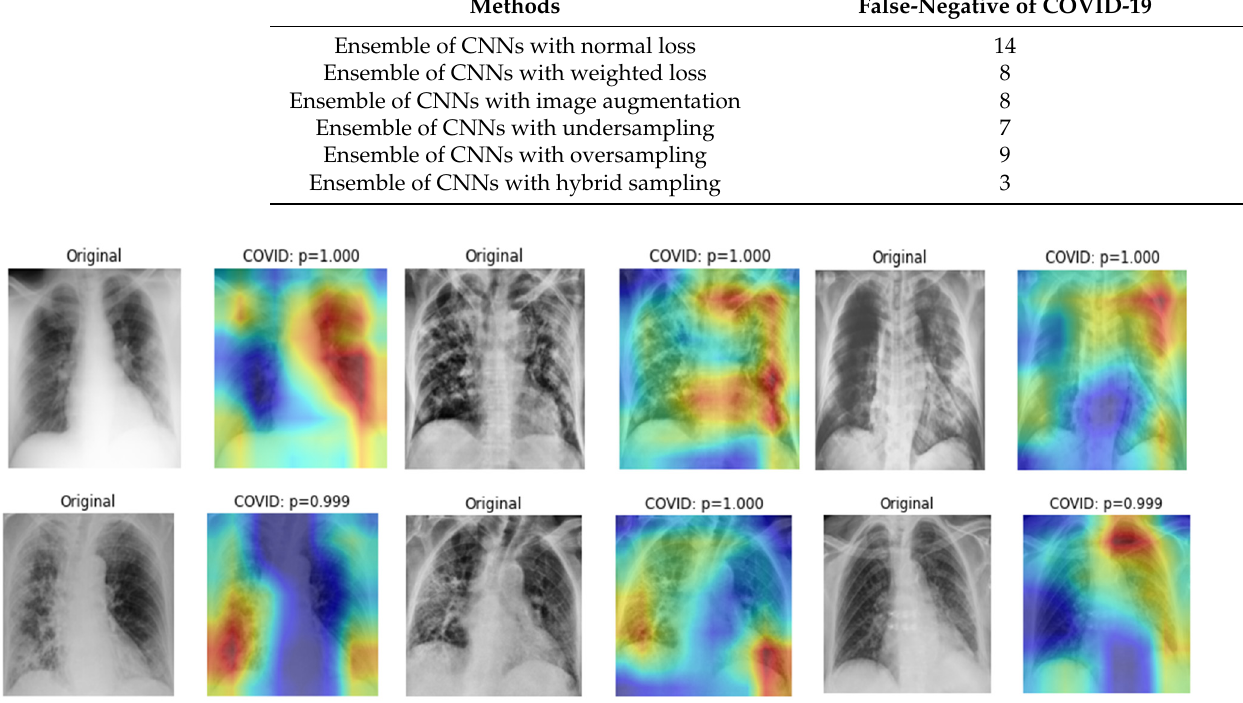
Table 11. False-negative of COVID-19 (misclassification of COVID-19 CXRs as normal and pneumonia).